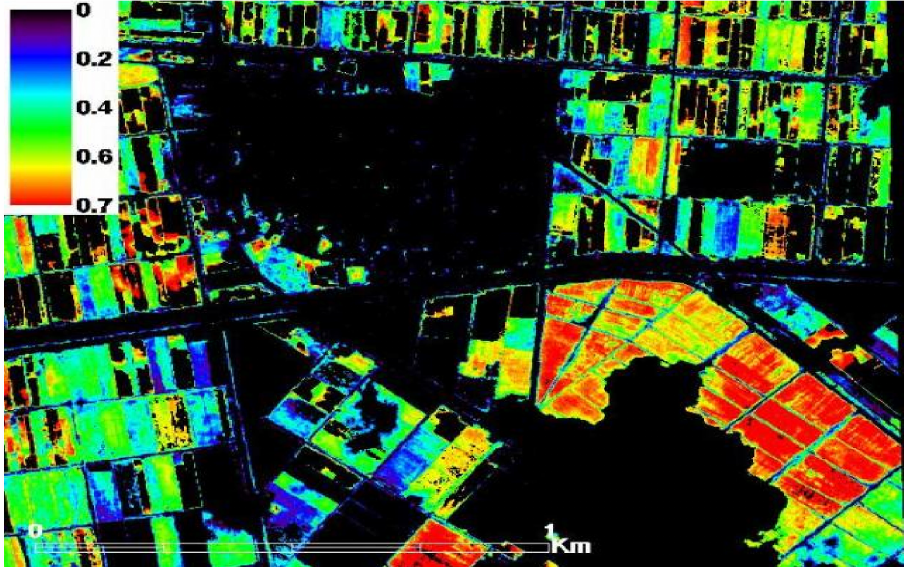
Figure 2. NDVI extracted from high resolution QuickBird imagery for wheat health status (non-stress and stressed) within the first study site, elnaser, Nile Delta,